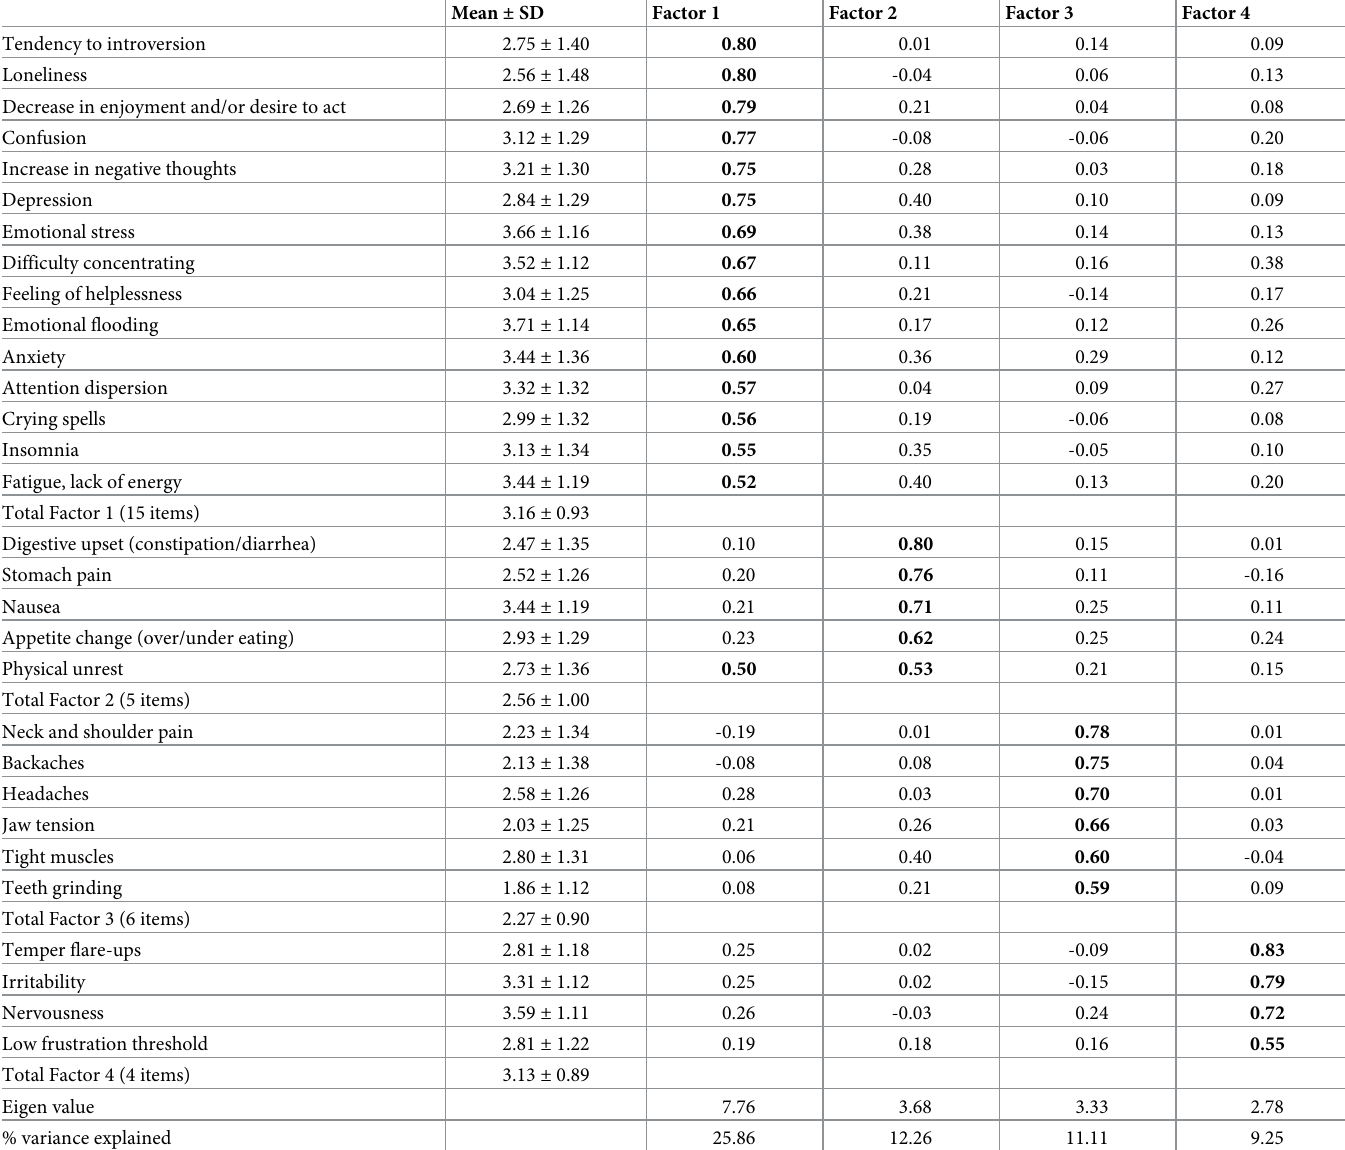
Table 1. Mean standard deviations and factor loadings of stress responses: Study